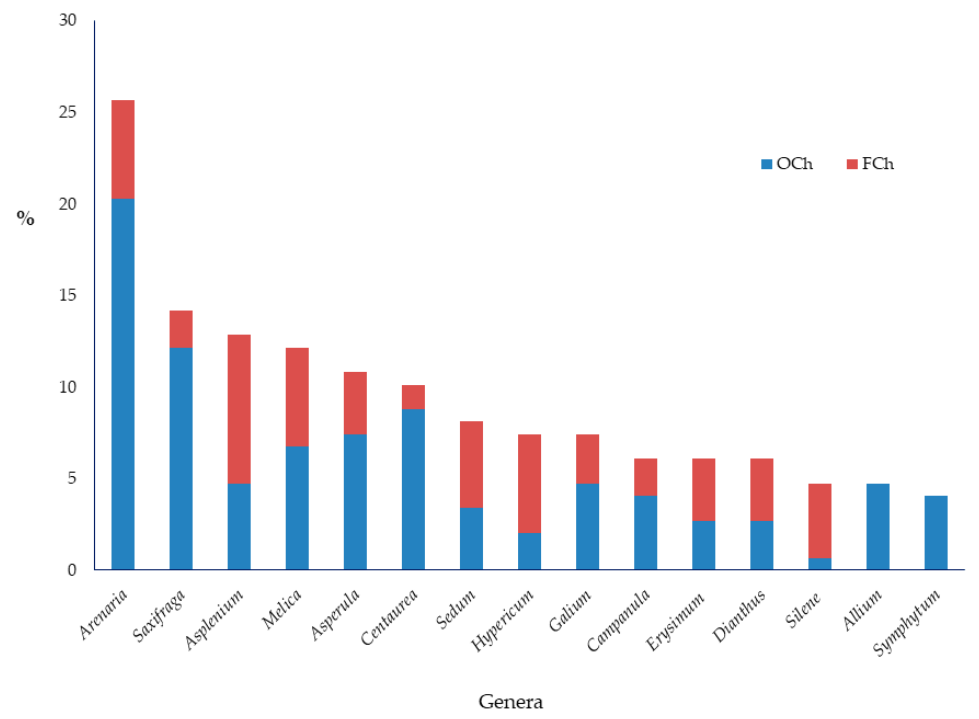
Figure 3. Richest in taxa genera of the Aegean chasmophytic flora. Each bar represents the % representation of each genus in the total chasmophytic flora as composed by the proportion of the representation of OCh (obligate chasmophytes) plus FCh (facultative chasmophytes).